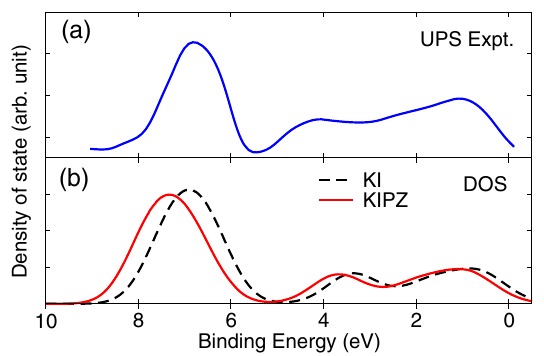
FIG. 3. Density of states (DOS) of ZnO computed with (b) the KI and KIPZ functionals, in comparison with (a) the experimental ultraviolet photoemission spectra (UPS expt.)